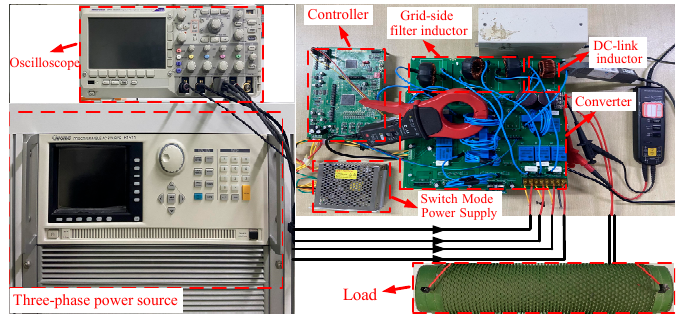
Figure 9. Experimental system of a three-phase current source converter. Table 4. System and control